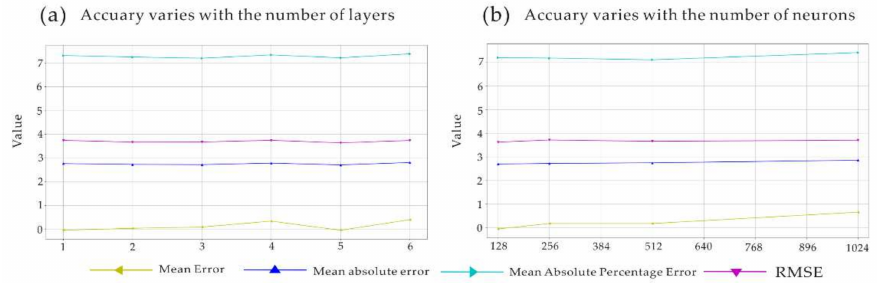
Figure 7. The process of adjusting the parameters for deep learning (the mean error, mean absolute error, mean percentage error, and RMSE are the average in the process of 10-fold